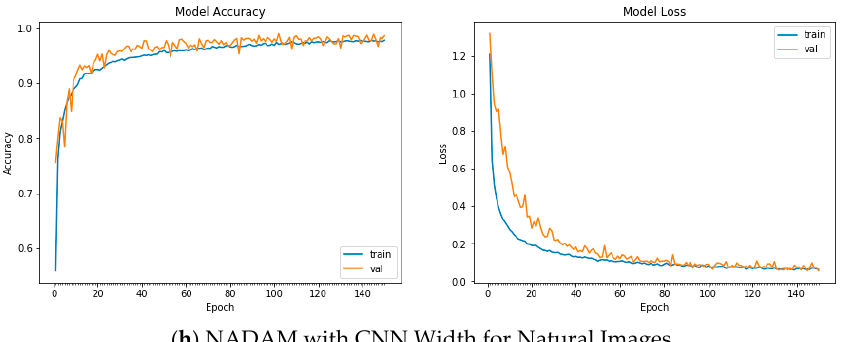
Figure A5. Plots of Train and Validation Test accuracies and losses of the CNN model with varying width for Natural Images: ( a ) Vanilla SGD; ( b ) SGD momentum; ( c ) SGD Nesterov momentum; ( d ) ADAGrad; ( e ) RSMProp; ( f ) ADADelta; ( g ) ADAMax; ( h ) NADAM.